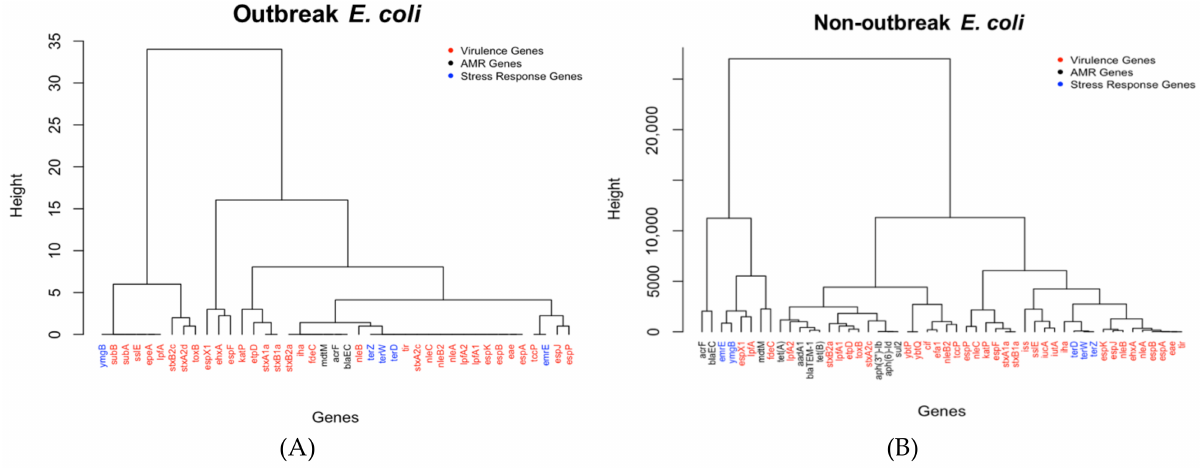
Figure 1. The dendrograms of outlier genes identified for ( A ) outbreak E. coli isolates and ( B ) non-outbreak E. coli